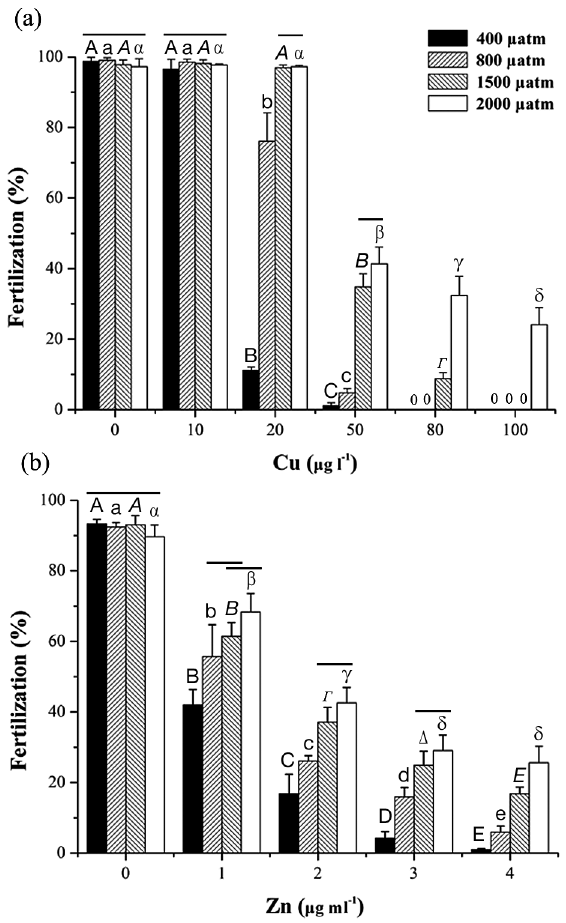
Fig. 2. Fertilization rate (mean + SD, n = 4) of Crassostrea angu- Fig. 3. Fertilization rate (mean + SD, n = 4) of Haliotis discus lata 2 h post fertilization at 4 levels of pCO 2 with the addition hannai 2 h post fertilization at 4 levels of pCO 2 with the ad- of (a) Cu or (b) Zn. Different upper- and lowercase letters re - dition of (a) Cu or (b) Zn. Different upper- and lowercase let- present significant differences between trace metal concen- ters represent significant differences between trace metal trations at the same pCO 2 level (p < 0.05). A line above col umns concentrations at the same pCO 2 level (p < 0.05). A line indicates no significant difference across pCO 2 levels at the above columns indicates no significant difference across pCO 2 levels at the same trace metal concentrations. Columns same trace metal concentrations. Columns not connected by lines are significantly different from each other (p < 0.05) not connected by lines are significantly different from each other (p < crease at a pCO level of 400 µatm, yet this effect de - 2 in creased. For example, at 400 µatm, creased as pCO 2